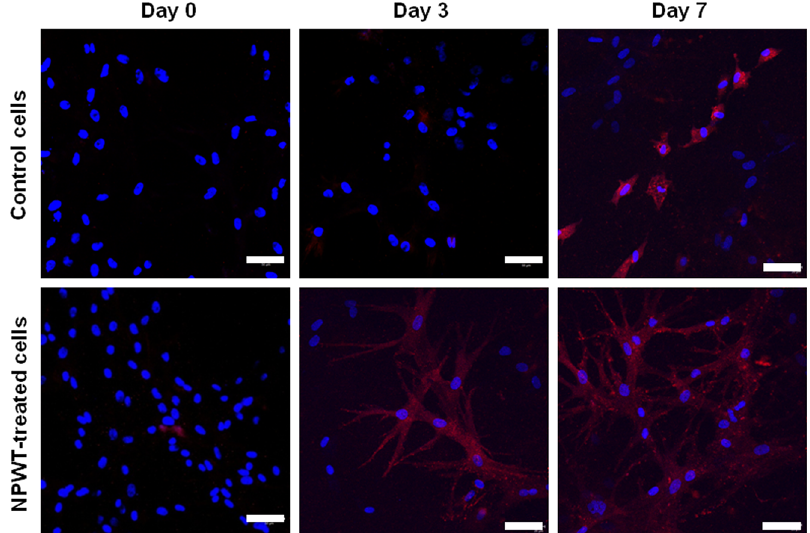
Figure 5. Immunofluorescence staining for COL1. Immediately before and 3, 7 days after incubation, cell clots were harvested and confocal microscopy was performed to detect fluorescent immunostaining for COL1. Results showed that the expression of COL1 was absent or weak in two groups before incubation, but stronger in NPWT group at day 3 and 7 after incubation. Bars=50 m m.